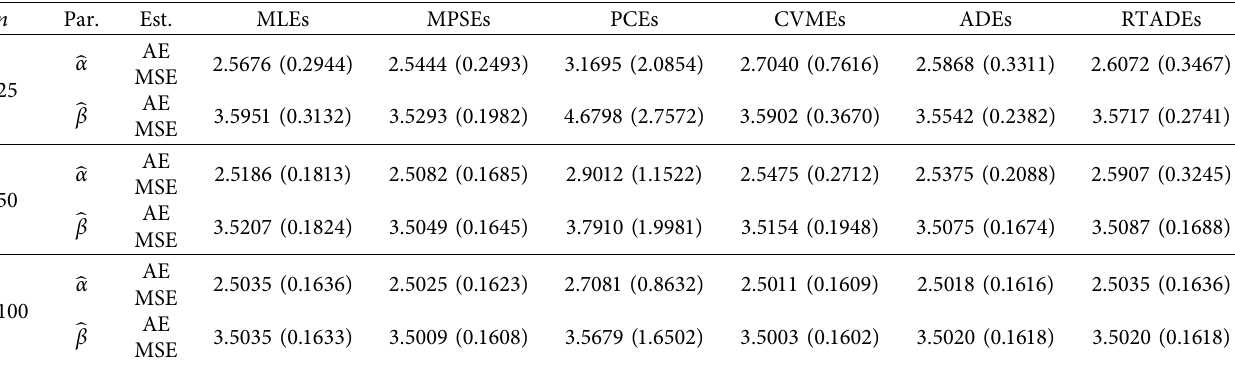
Table 7: The AEs and MSEs for ( α � 2 . 5 and β � 3 . 5 ) T .